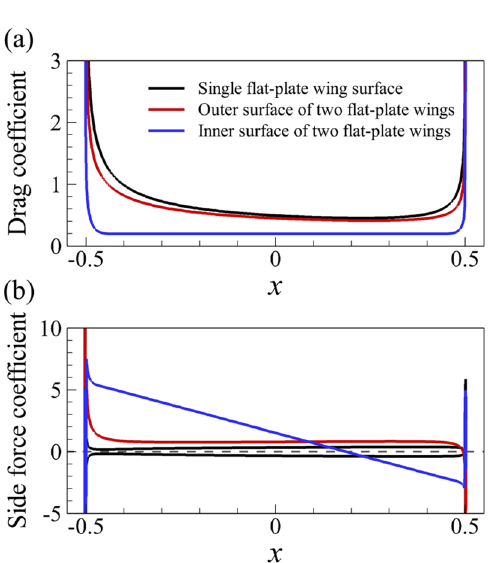
C D = D /(0.5 ρU 2 c ) and C S = S /(0.5 ρU 2 c ), respectively, as shown in Table 1 for the single wing and the double wings with W = 0.1 c . As shown in Table 1, for the flat-plate wings, the drag coefficient of one of two wings (only 0.863) is 43% lower than that of the single one (about 1.511); while for the bristled wings, one of two wings (only 0.852) is also 43% lower than that of the single one (about 1.490). Comparing the drag coefficients between the flat-plate and bristled wings, it is seen that the latter approximately reaches 99% of the former, whether for both the single wing or each of double wings. Therefore, single wing produces about 1.75 times more drag than one of the double wings regardless of whether they are bristled or flat-plate wings. As shown in the Table 1, the side force of each one of the two flat-plate wings is 1.211, which is larger than that of the bristled wings (0.145) by about an order of magnitude. During flight, the insects need to make an effort to overcome the side forces for keeping the two wings from separating from each other. Thus, if the smallest insects use membrane wings, their flight muscles need to overcome very large side forces, whereas using bristled wings does not have this problem. Therefore, bristled wings can be beneficial during upward movement, which may be one reason why most of the smallest insects adopt them. In summary, for the bristled wings, each one of two wings generates less drag forces than the single wing;